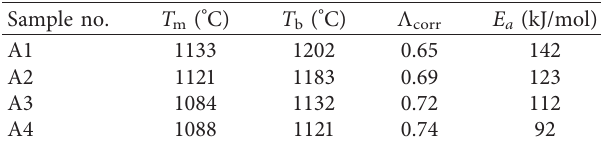
Table 4: Melting temperature ( T rected optical basicity ( Λ corr ), and viscous activation energy of experimental slags. Sample